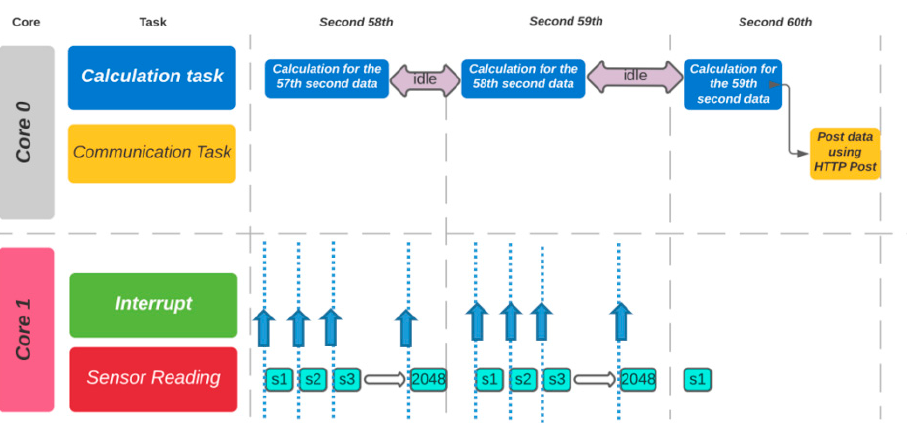
Figure 4. Timing diagram of the tasks for both cores.